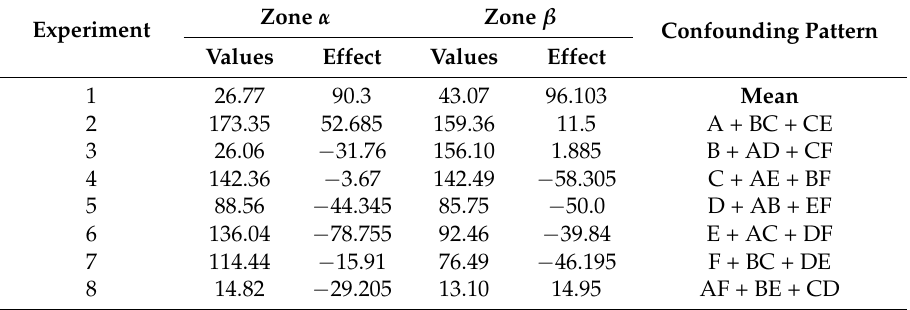
Table 8. Mean values and standardized effects for the mean Feret diameter ( F mean ).